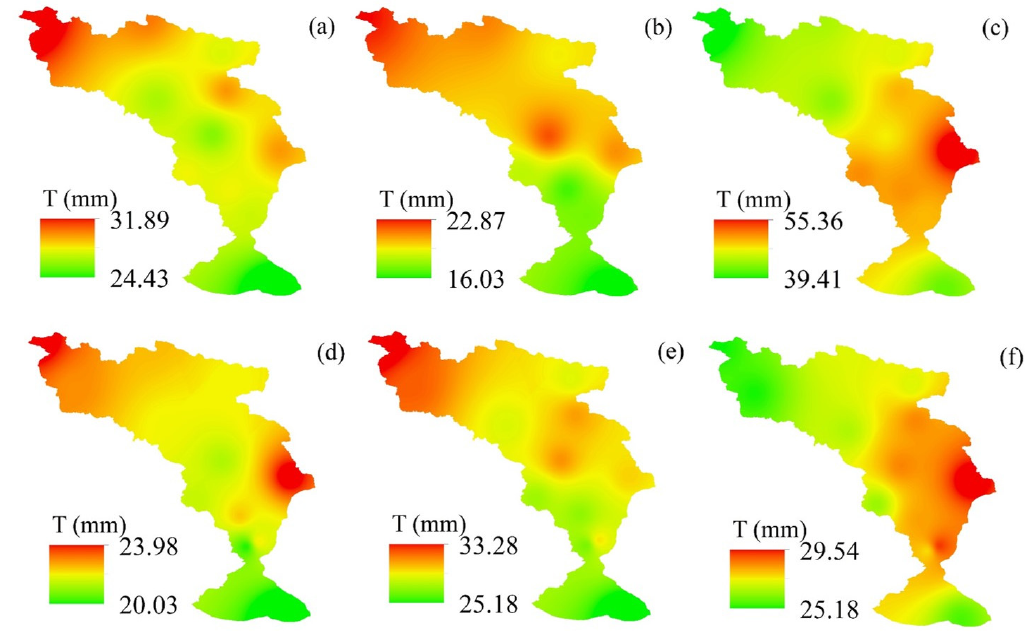
Figure 7. Spatial variation of plant transpiration ( T ) value in summer 2018 ( a – c ) and 2019 ( d – f ).